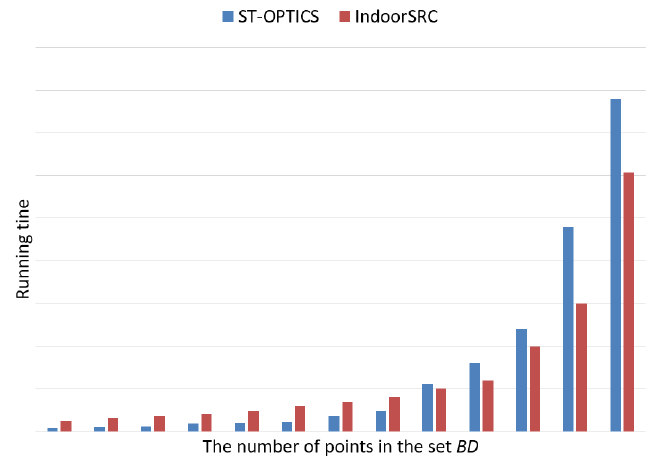
Figure 9. Comparison of the running time with the baseline approach.